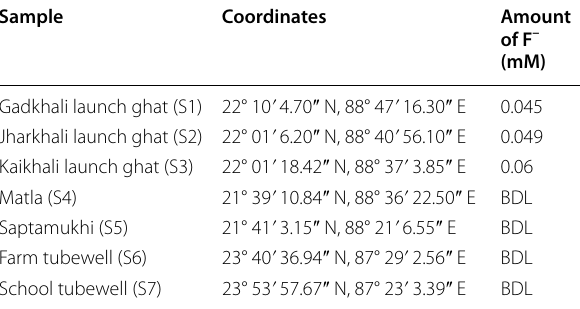
Table 4 Analysis of natural samples